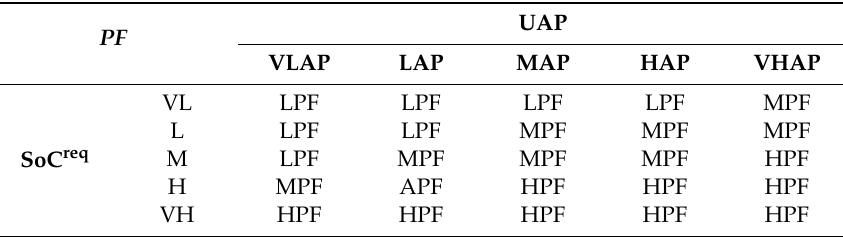
Figure 5. Membership functions of the fuzzified input and output variables for the second stage FIS: ( a ) Membership functions of remaining parking duration; ( b ) Membership functions of required SoC; ( c ) Membership functions of updated available power; ( d ) Membership functions of preference. Table 2. Set of fuzzy rules of second stage FIS when RPD is SD.